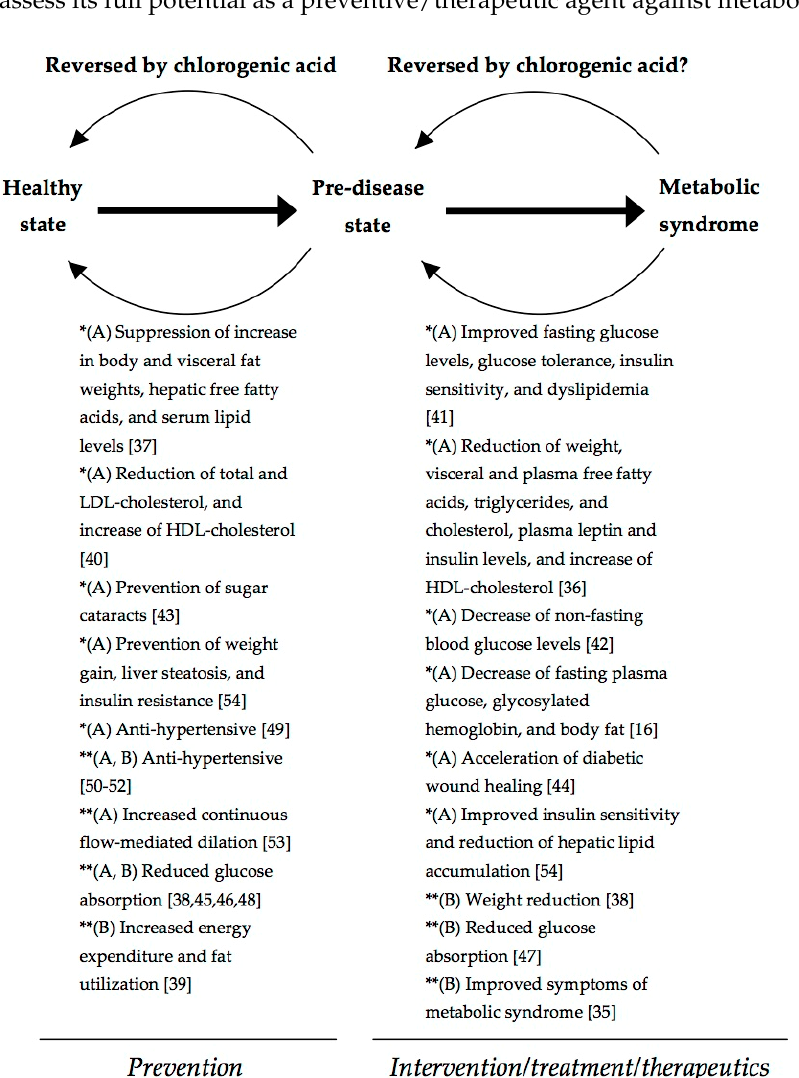
Figure 2. Proposed model for preventive and therapeutic effects of chlorogenic acid (A) or chlorogenic acid-rich foods and supplements (B) over metabolic syndrome based on in vivo studies (*) and clinical studies (**).